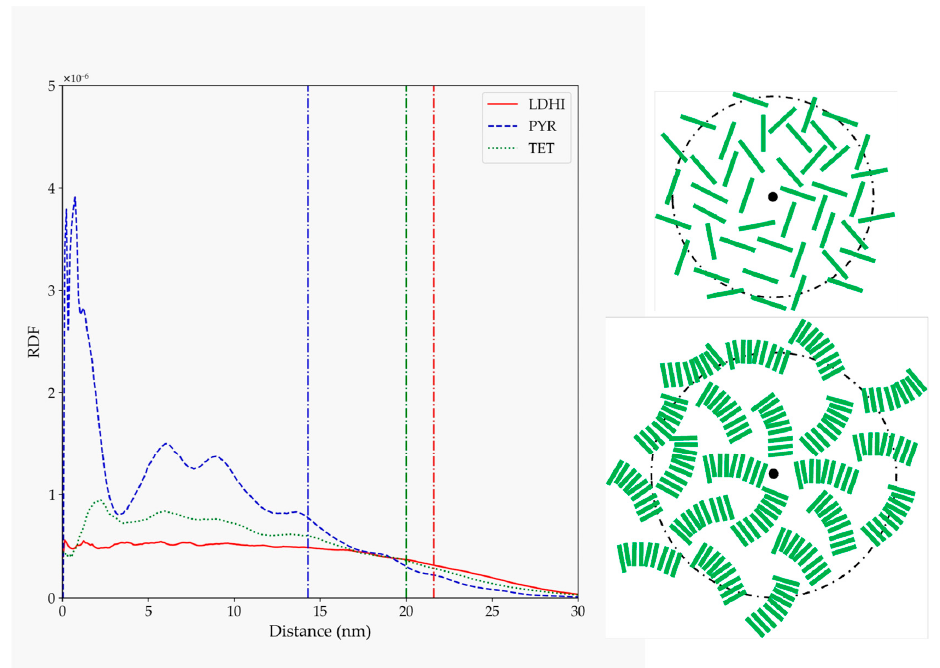
Figure 9. Radial distribution function of the rings of different monomer units (referred to their centers of mass) relative to the nanosphere center of mass for the large nanosphere models ( l DHI: red; PYR: blue; TET: green), in the simulations with implicit solvent. The vertical lines indicate the average approximate value of the radius of gyration for each of the systems. The schemes on the right are simplified depictions proposed for l DHI and TET-1 ( top ), and for PYR ( bottom ) from the overall geometry and the RDF